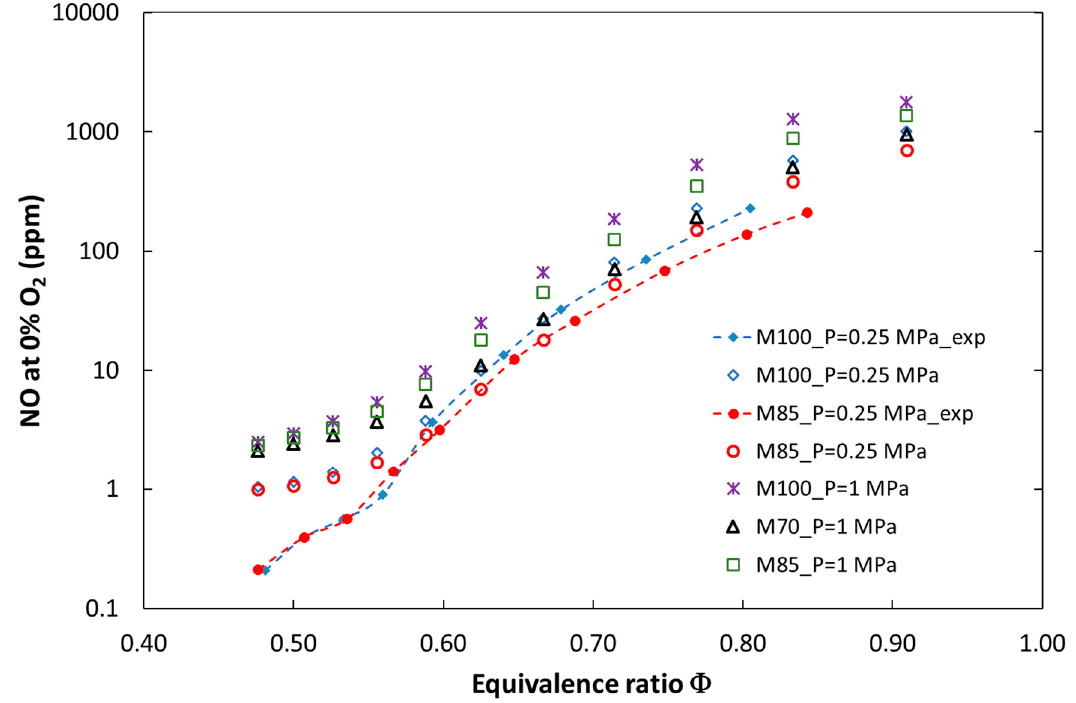
Figure 3. Calculated and experimental NO emissions for the tested fuels at elevated combustion pressures of 0.25 MPa and 1 MPa.